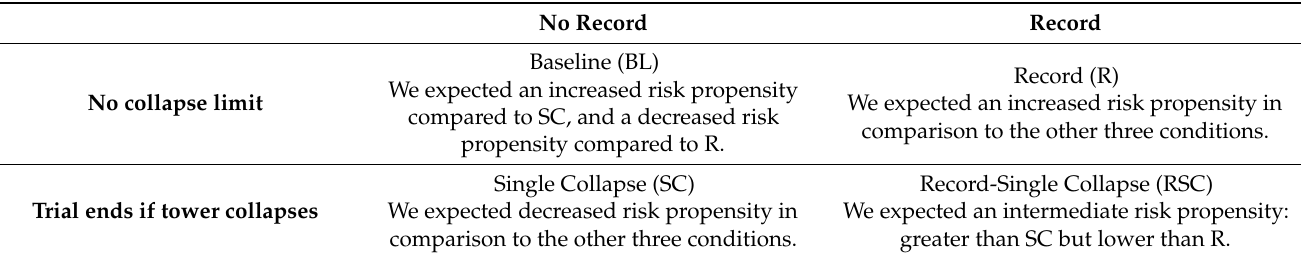
Table 1. Methodological modifications resulting in four